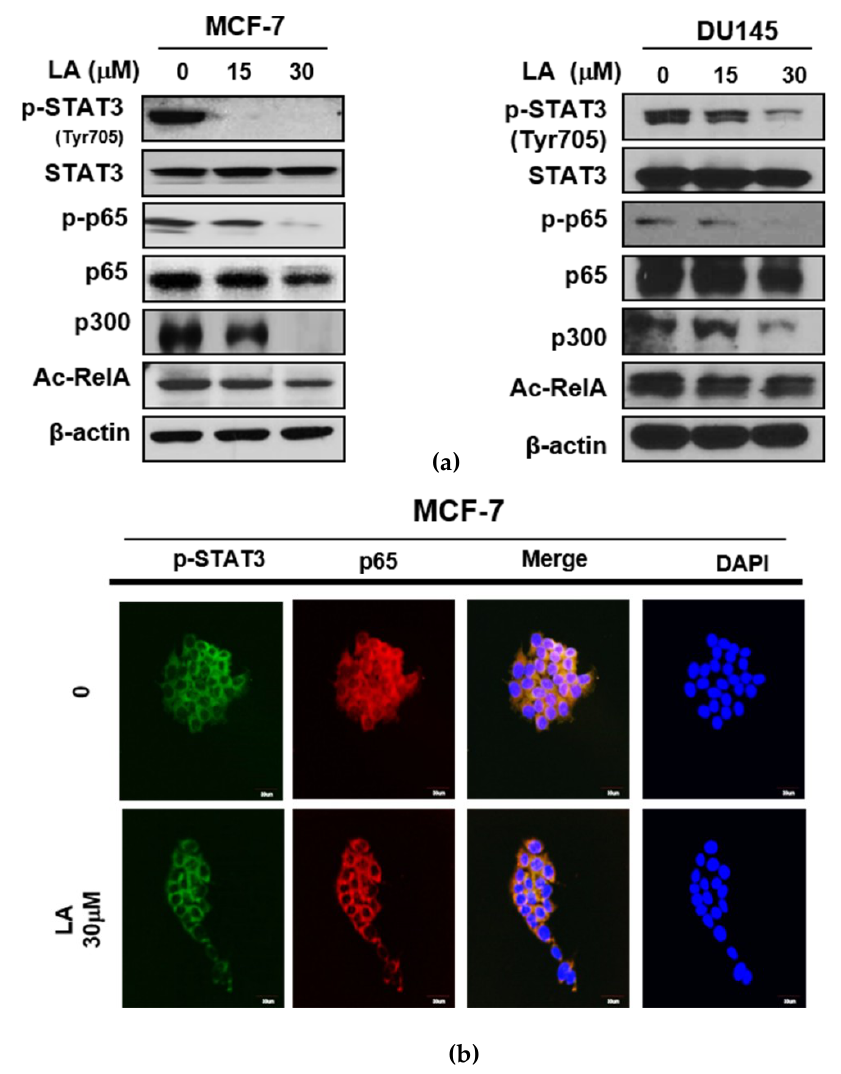
Figure 2. E ff ect of LA on the expression of the p-signal transducers and activators of transcription 3 (STAT3), p-NF- κ B, p300, and Ac-RelA, and their nuclear translocation in MCF-7 and DU145 cells. ( a ) E ff ect of LA on p-STAT3, p-NF- κ B, p300, and Ac-RelA in MCF-7 and DU145 cells. The cells were treated with LA (0, 15, and 30 µ M) for 24 h, and were subjected to Western blotting for p-JAK2, p-STAT3, STAT3, p-p65 / RelA, NF- κ B. p300, and Ac-RelA. ( b ) E ff ect of LA on nuclear translocation in the MCF-7 cells. Immunostaining was conducted with antibodies of p-STAT3 and RelA / p65, and secondary fluorescein isothiocyanate (FITC)-conjugated antibody in the MCF-7 cells treated with or without LA.